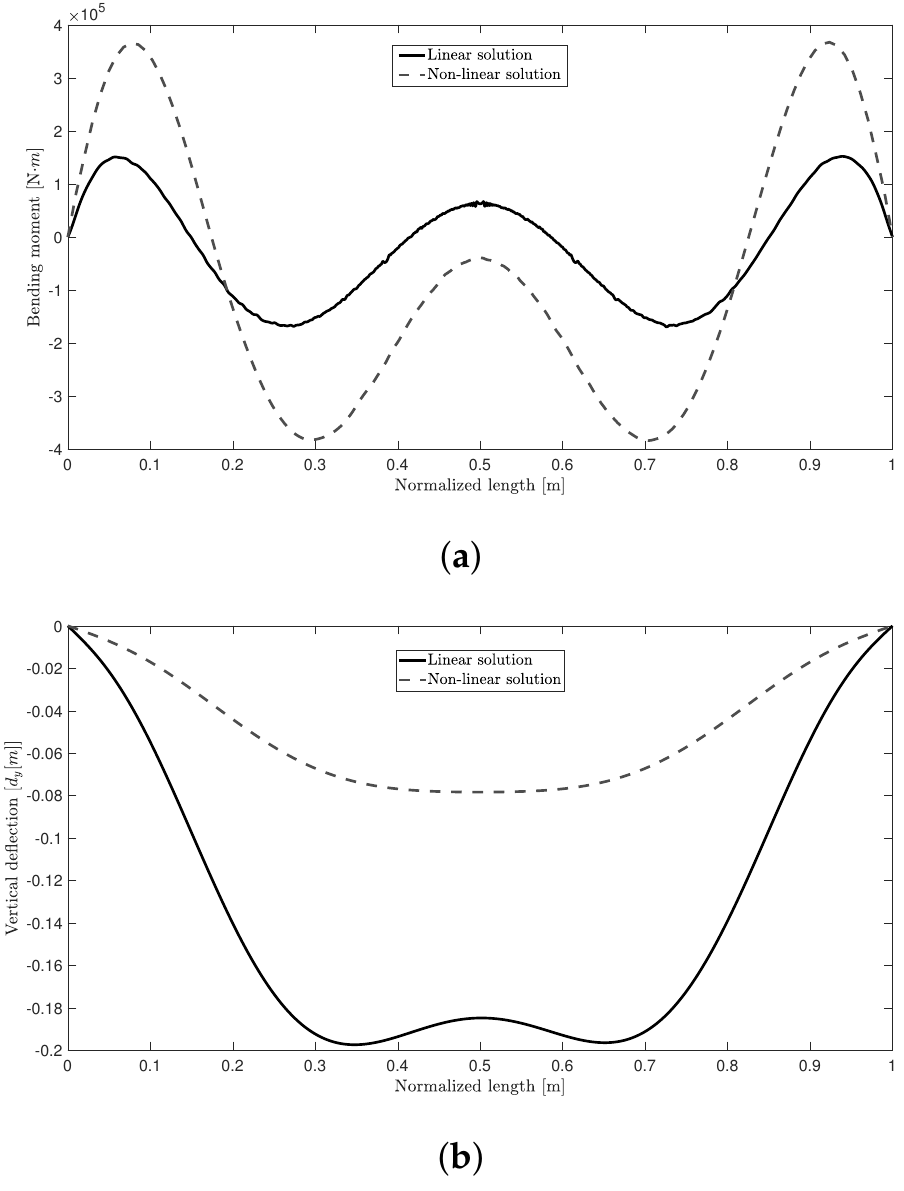
Figure 9. Bending moment ( a ) and vertical deflection comparative ( b ) for linear ( solid line ) and nonlinear ( dashed line ) in the case in which the height B is fixed.